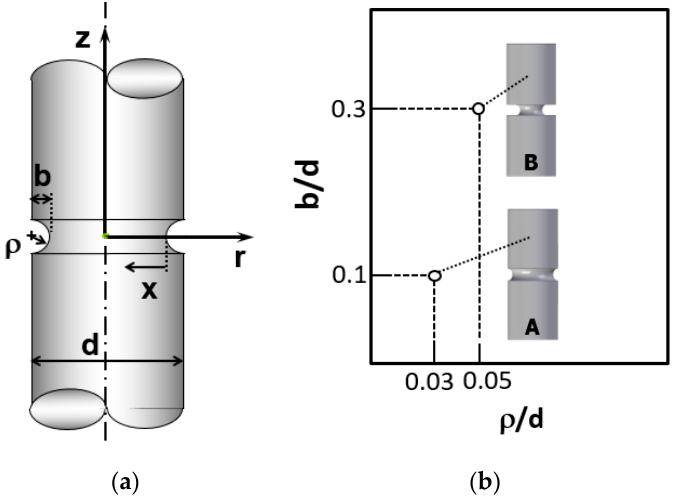
Figure 1. ( a ) Scheme of a notched wire including the parameters used for defining the notch geometry and ( b ) values of the dimensionless notch parameters used in notched wires A and B.